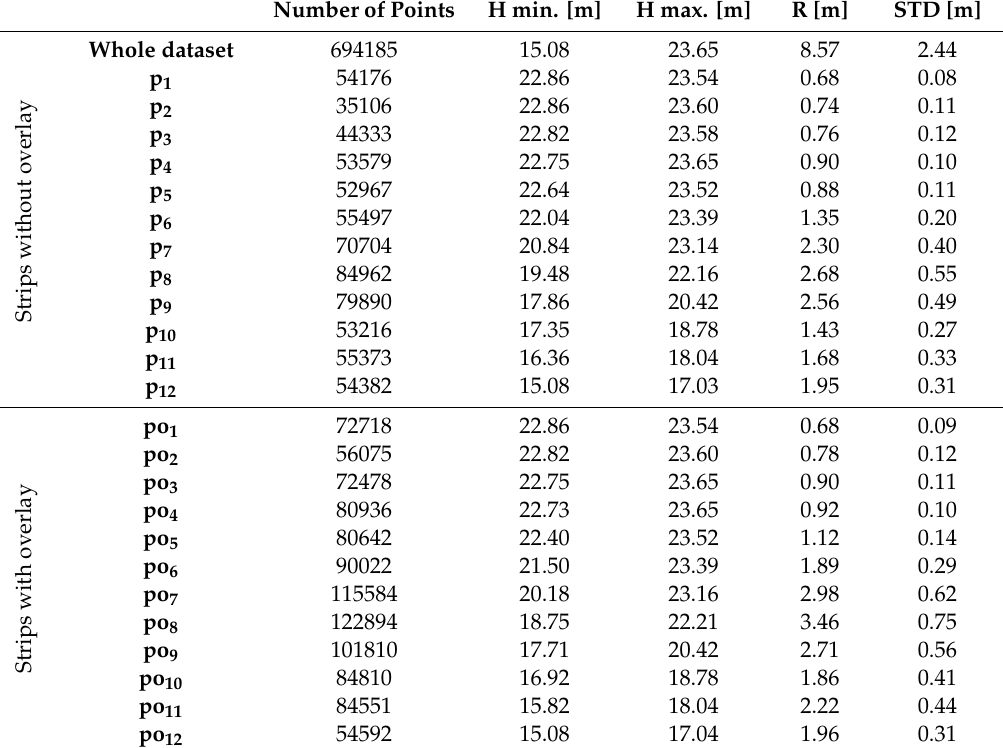
Table 1. Statistical characteristics for datasets in methodology v1.